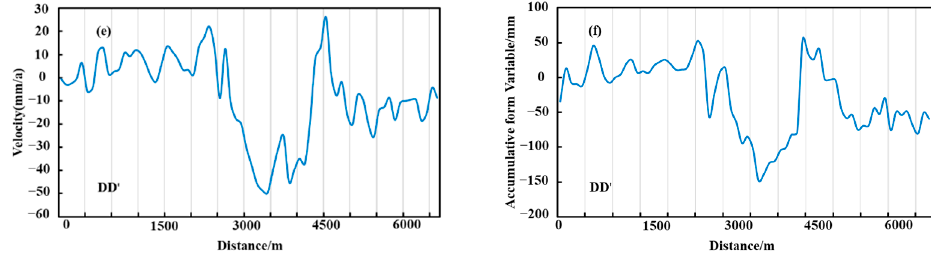
Figure 11. Cross-sectional deformation features. ( a , c , e ) the Cross-sectional deformation rate, ( b , d , f ) the cumulative deformation variable.